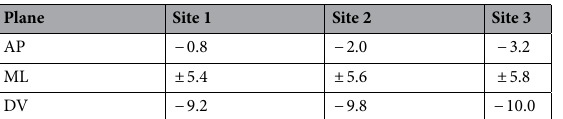
Table 1. Coordinates for ibotenic acid infusions into the pPCX to all extended damage across the rostral- caudal